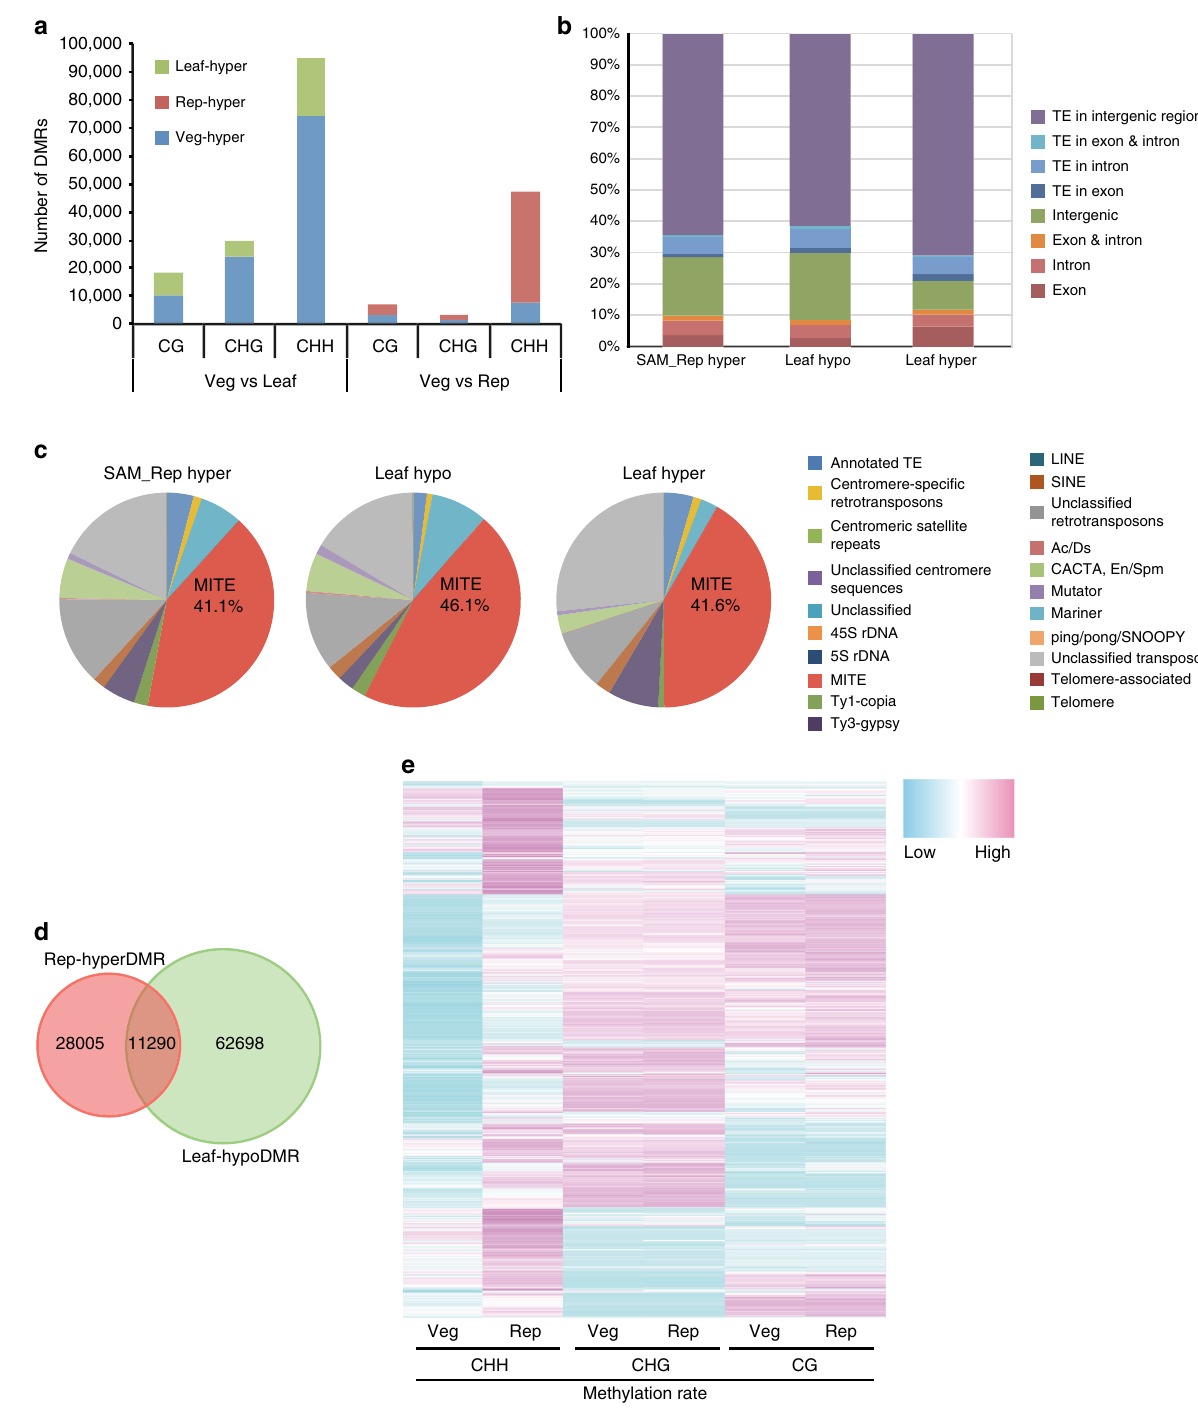
Fig. 3 CHH hypermethylation occurs mainly on TEs. a Numbers of DMRs between vegetative SAM and mature leaf (Veg vs. Leaf) and between vegetative SAM and reproductive SAM (Veg vs. Rep). Green, blue, and red indicate the portion of DMRs that are hypermethylated in mature leaf, vegetative SAM, and reproductive SAM, respectively. b , c Genomic features b and TE families c overlapping with CHH DMRs that are hypermethylated in reproductive SAM compared with vegetative SAM (left, SAM_Rep hyper), hypermethylated in vegetative SAM compared with mature leaf (middle, Leaf_hypo), and hypermethylated in mature leaf compared with vegetative SAM (right, Leaf_hyper). d Venn diagram showing the overlap of CHH DMRs between Rep- hyperDMRs and Leaf-hypoDMRs. e Heat map showing the methylation level for each context in the vegetative SAM (Veg) and reproductive SAM (Rep) for